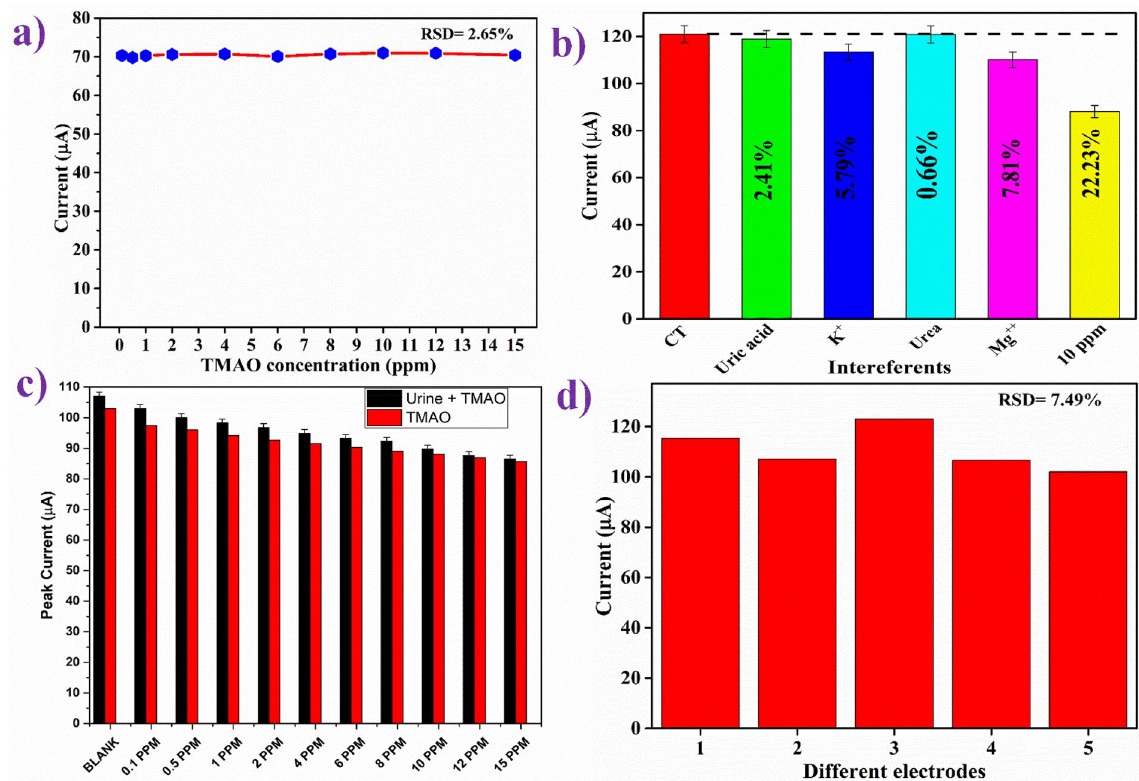
Figure 5. ( a ) Control experiment using DPV of NIP/ITO electrode as a function of TMAO concentration (0.1– 15 ppm mL −1 ); ( b ) Effect of potential interferents on the response study of MIP/ITO electrode; ( c ) Spiked-in sample response of MIP/ITO electrode in comparison with response study of TMAO; and ( d ) Reproducibility study of MIP/ITOelectrode fabricated under similar condition.